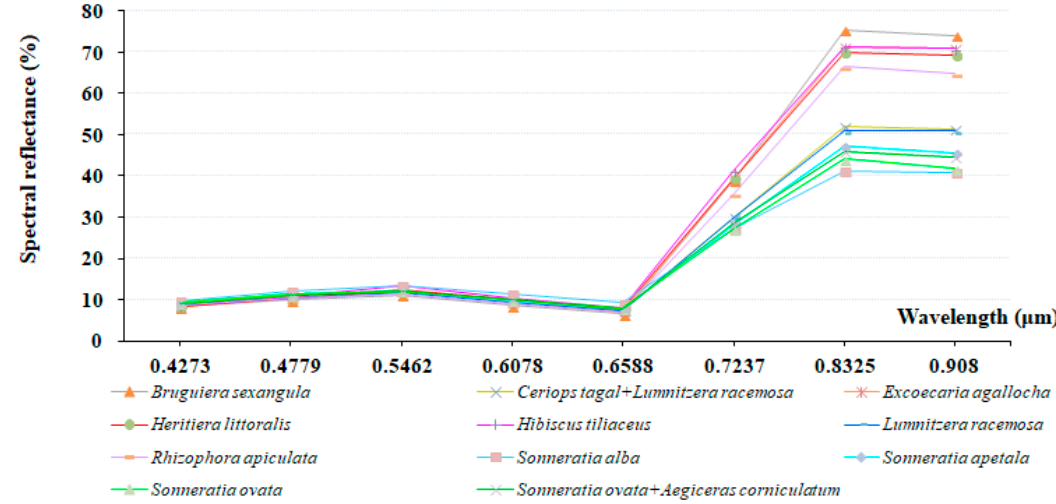
ff erent mangrove